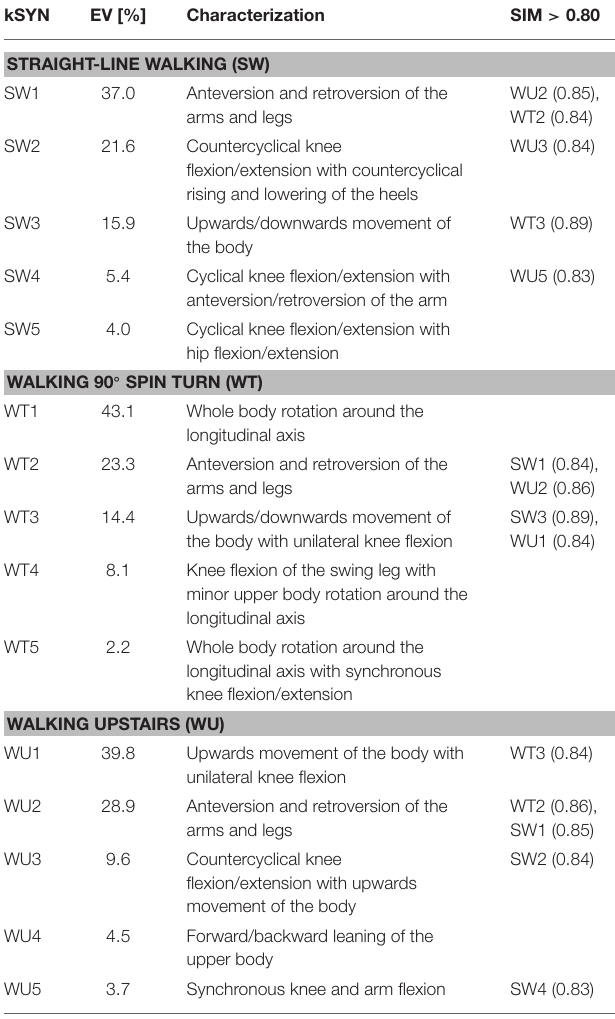
TABLE 1 | Description of the first five kinematic synergies (kSYN) of the three different locomotion tasks. kSYN EV [%] Characterization SIM >